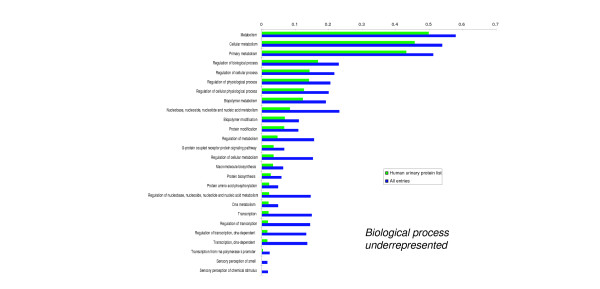
Significantly under-represented GO biological process terms for the set of identified urinary proteins. Each term was selected as described in the legend of Figure 6. GO, Gene Ontology.